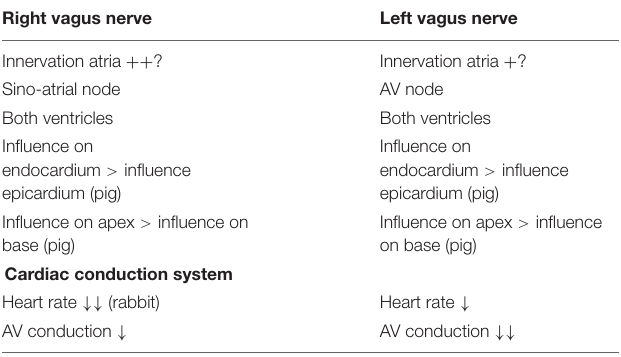
TABLE 2 | Summary of functional characteristics of the right and left sided vagus nerves.